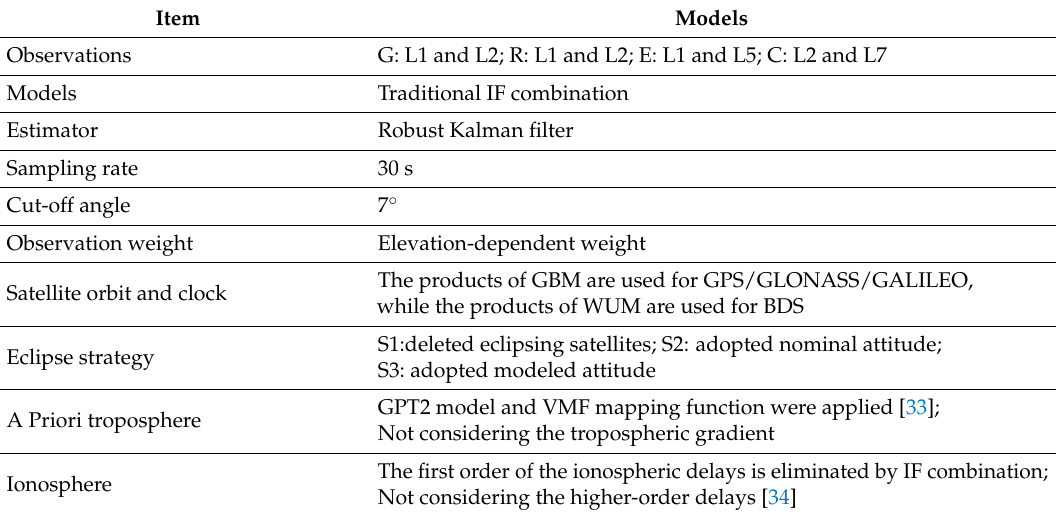
Table 3. The GNSS PPP model and its